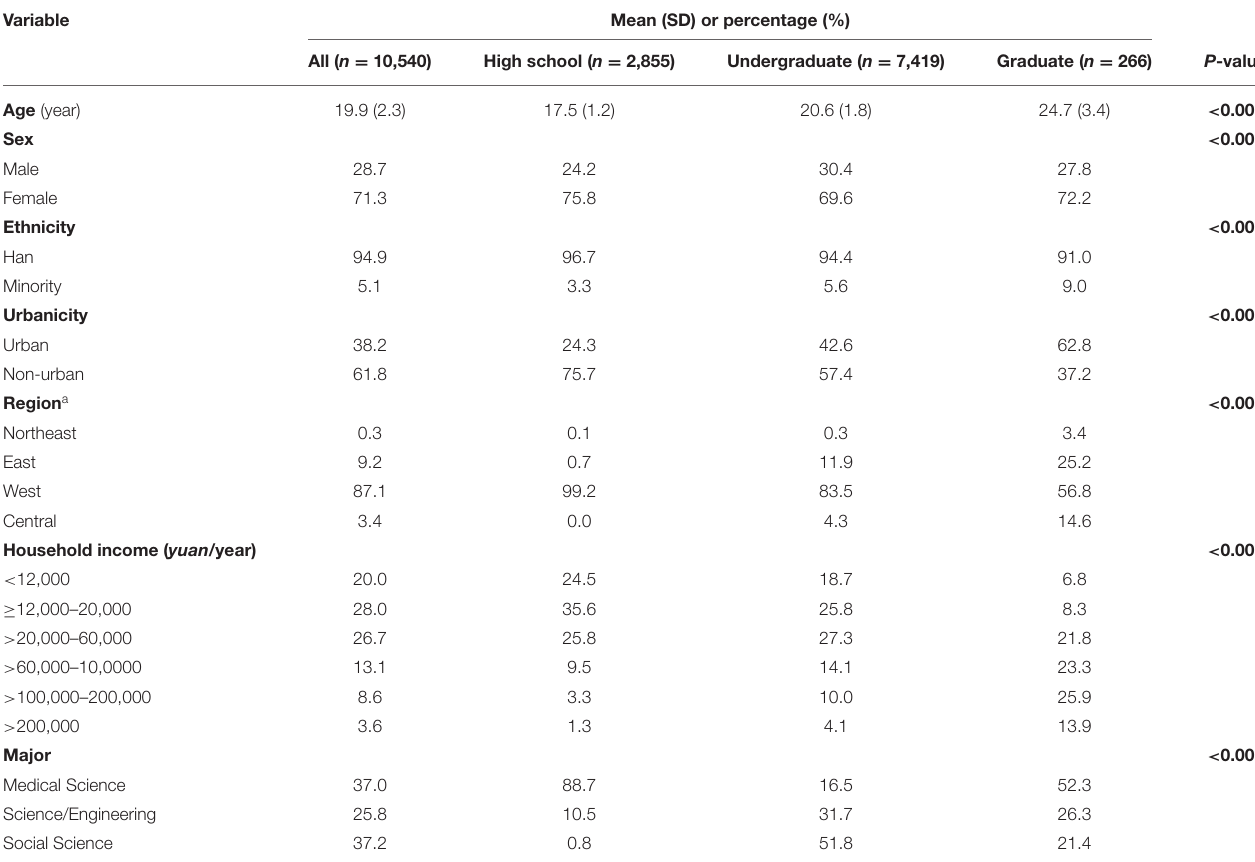
TABLE 2 | Baseline characteristics of the participating youths in the COVID-19 Impact on Lifestyle Change Survey (COINLICS).